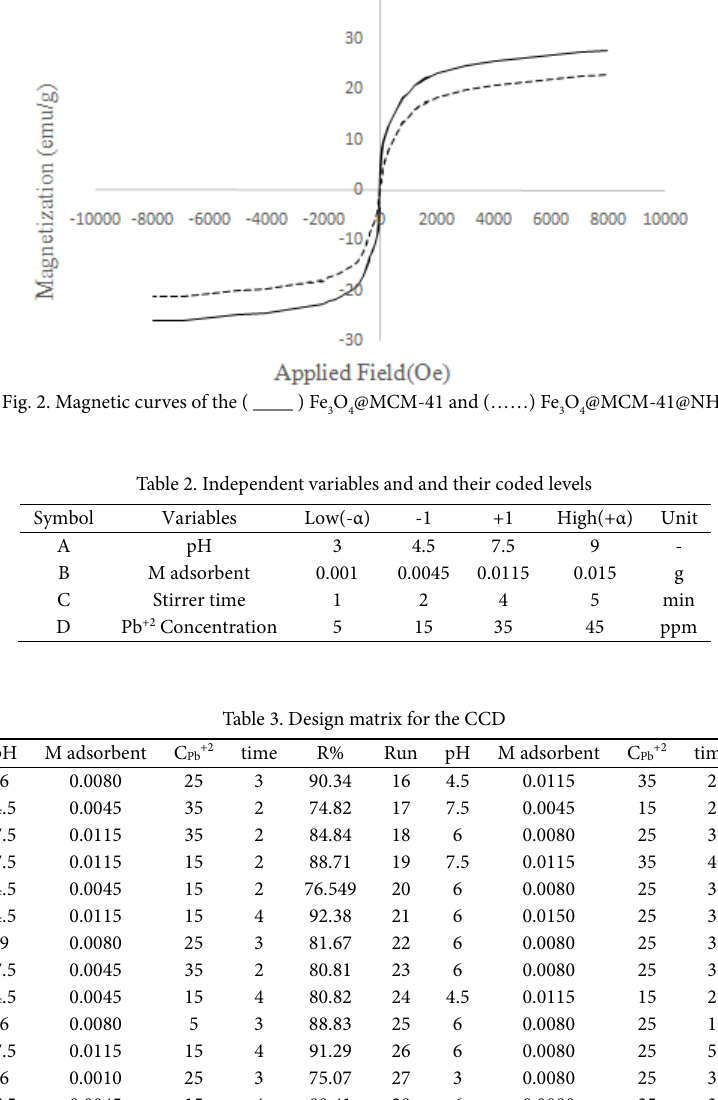
Table 3 Design matrix for the CCD.